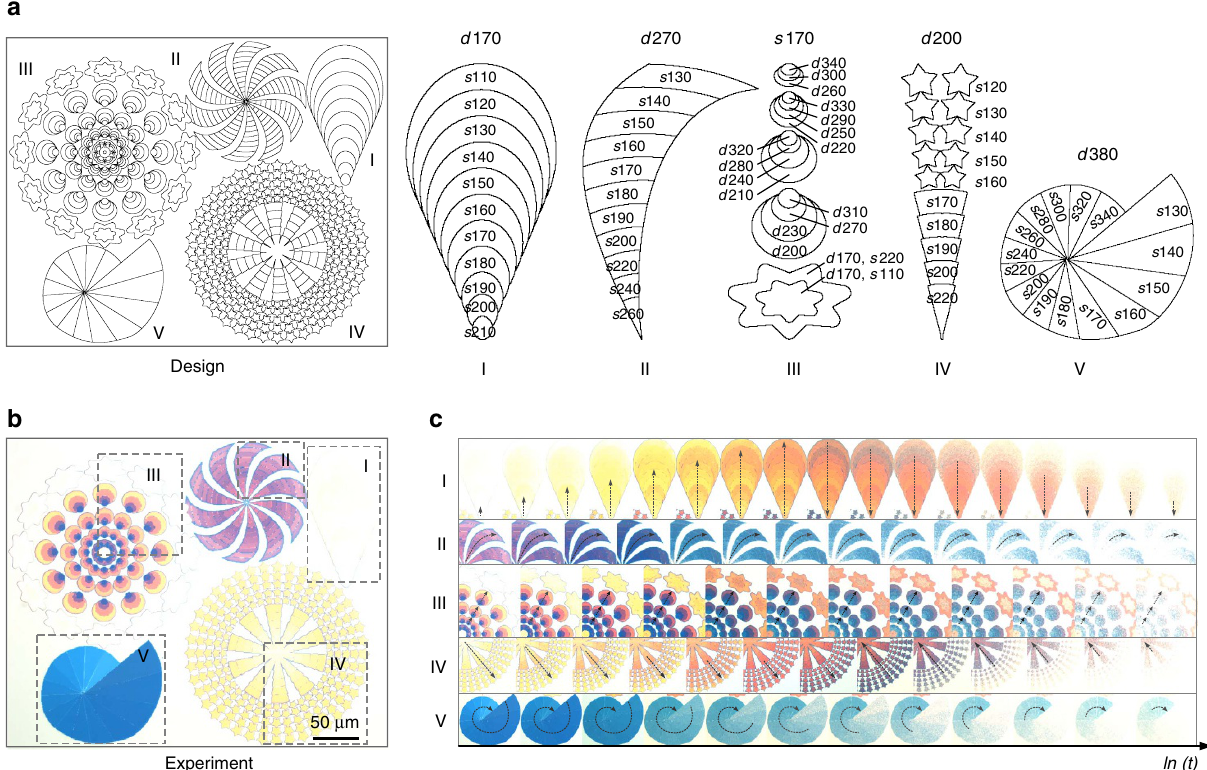
Figure 3 | Plasmonic subwavelength animations. ( a ) Schematics of the firework animations characterized with different dynamic effects. ( b ) Optical micrograph of the fireworks. ( c ) Selected snapshots of the firework animations over time ln(t) , illustrating the individual dynamic